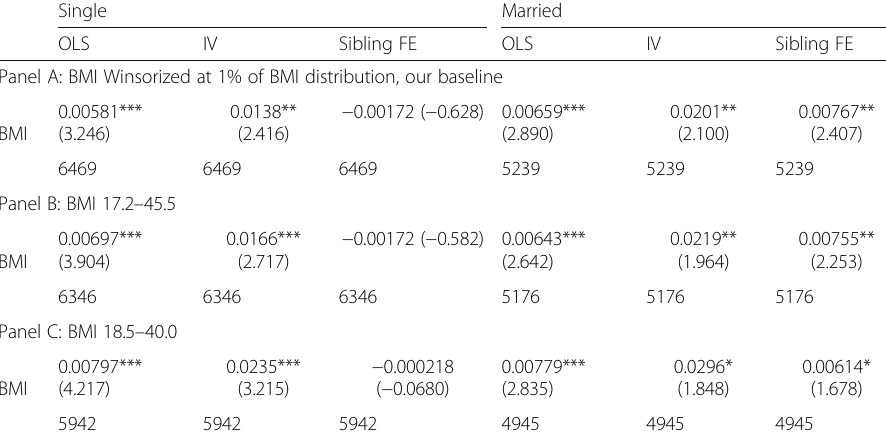
Observations Panel D: OLS results for married men BMI Control for wage